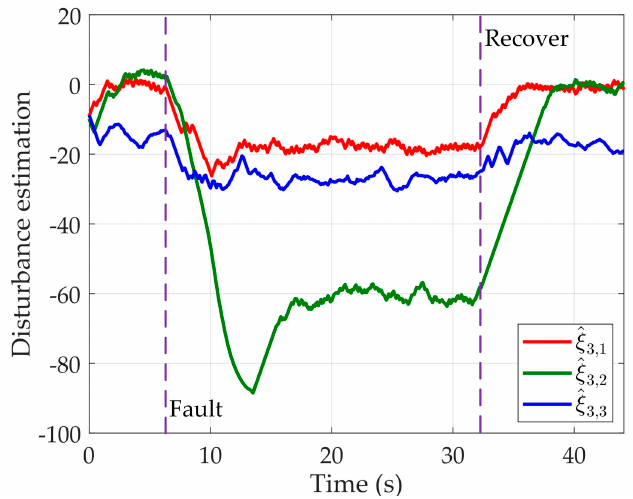
Figure 27. Curves of disturbance estimation.